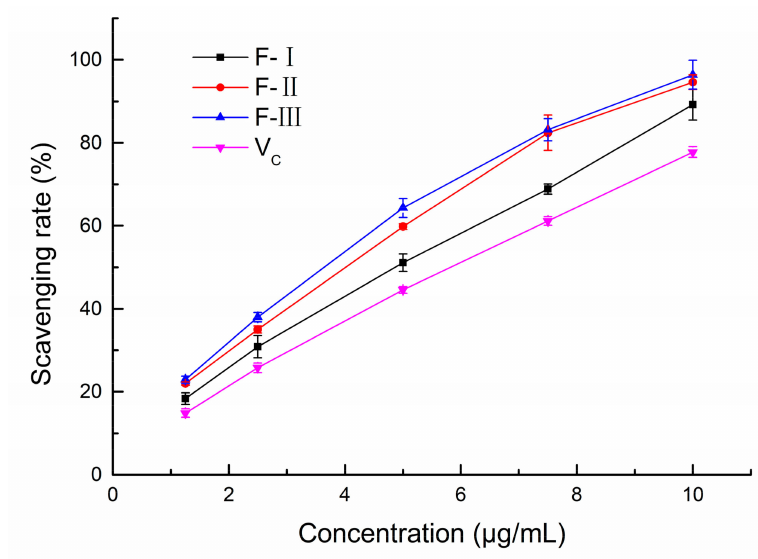
Figure 2. The capacities of three polyphenol fractions and vitamin C on 2,2 (cid:48) -azino-bis-3- ethylbenzthiazoline-6-sulphonic acid (ABTS + ) radicals.